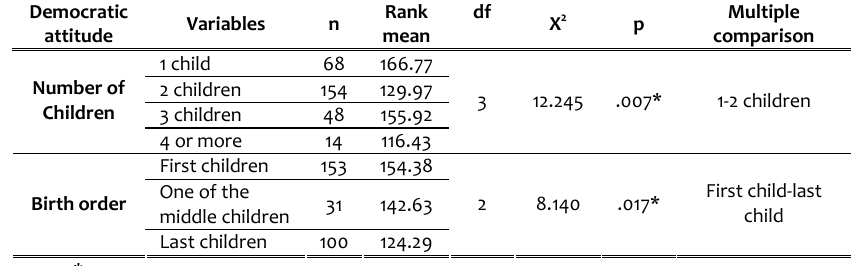
Table 5. Kruskal Wallis test related to PAS Democratic attitude subscale scores and the number